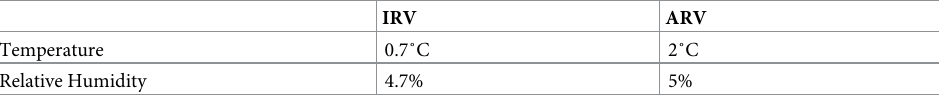
Table 3. IRV and ARV values. Values of temperature and relative humidity assumed as thresholds for the uniformity of greenhouse environmental